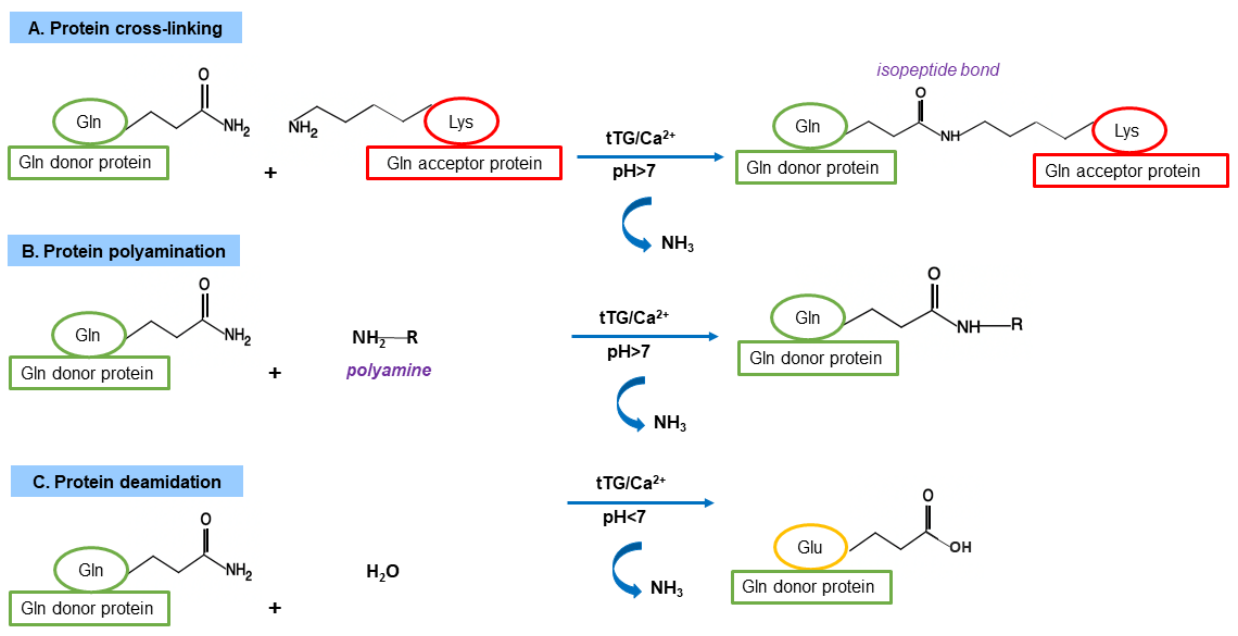
Figure 2. TG-catalysed acyl transfer reactions. ( A ). Cross-link formation between the γ -carboxamide group of a Gln residue and the ε -amino group of a Lys residue with the release of ammonia. ( B ). Reaction of incorporation of a polyamine into a Gln residue. ( C ). Deamidation of a Gln residue to a Glu residue. Table 1. Mammalian TGs. For each isoenzyme, the gene name, protein name, main localisations, and main biological functions are